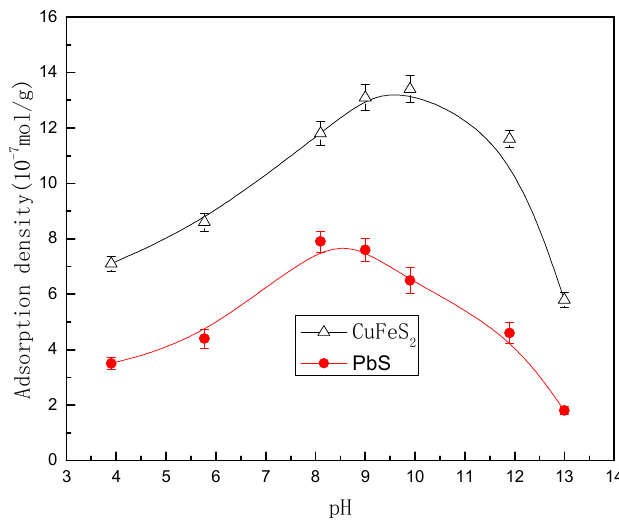
Figure 4. Effect of pH on IPETC adsorptionon chalcopyrite and galena surfaces (IPETC: 7 × 10 − 4 mol/L). HIPETC is the protonated (H + ) and molecular form of IPETC − (A − ) monobasic acid, thus HIPETC